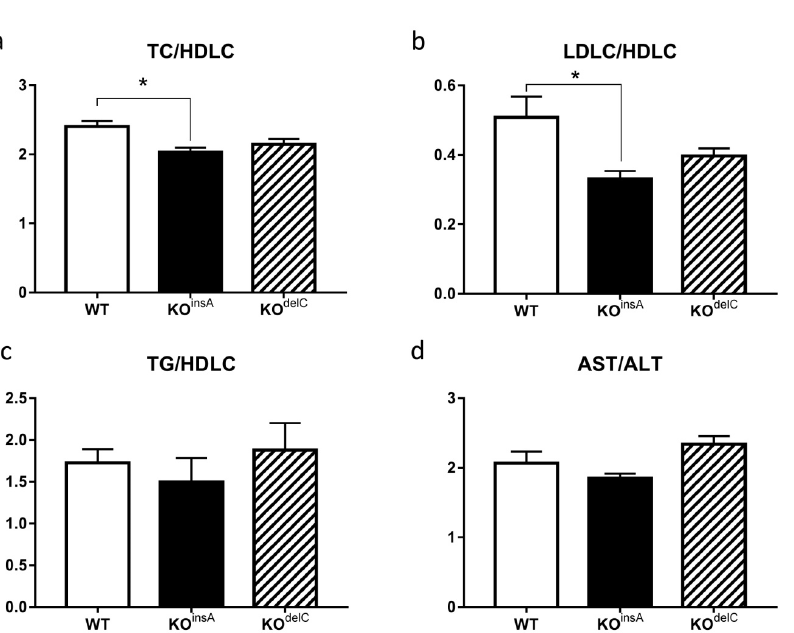
Figure 7. Comparative analysis of biochemical parameters in the blood of TAAR9-KO and WT rats. ( a ) Total cholesterol/high-density lipoprotein ratio (TC/HDLC), ( b ) ratio of low-density lipoprotein cholesterol and high-density lipoprotein cholesterol (LDLC/HDLC), ( c ) ratio of triglyceride/high-density lipoprotein cholesterol (TG/HDLC), ( d ) de Ritis ratio (AST/ALT). Biochemical analysis revealed a decrease in TC-to-HDLC ratio and LDL to HDL cholesterol, the main predictive factor of atherosclerosis in human [25], in TAAR9-KO rats, but statistical significance was observed only in TAAR9-KO insA strain. Data are mean ± SEM, * p < 0.05 vs. WT, ANOVA with Tukey’s post-hoc test, n = 7 per group.